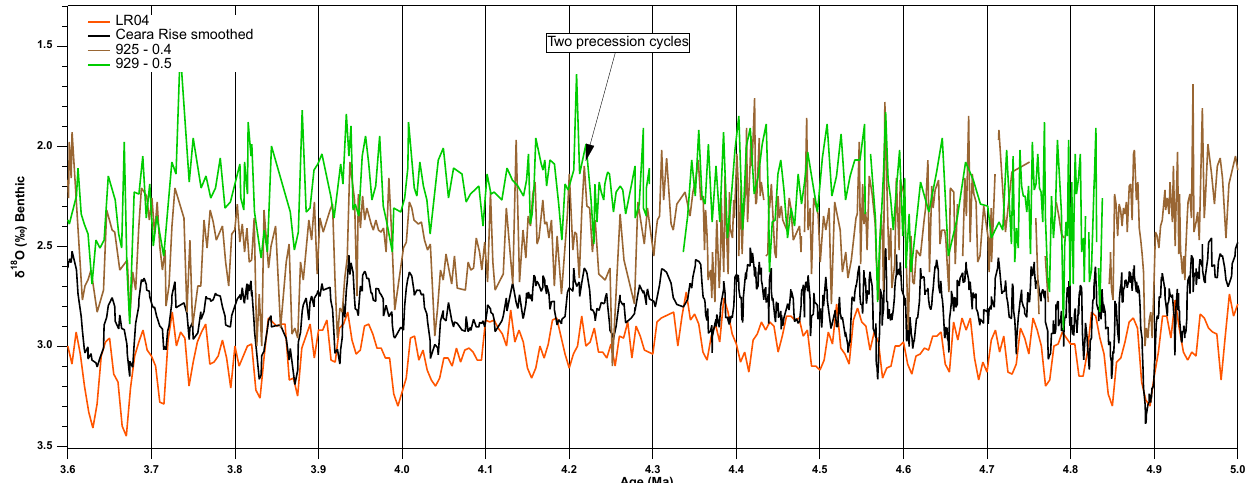
Figure 12. A comparison of LR04 and Ceara Rise (smooth) to Site 925 and Site 929 benthic isotope data. LR04 assignment of variability in the interval from 4.0 to 4.5Ma to precession peaks may have resulted in the mismatch with the Ceara Rise